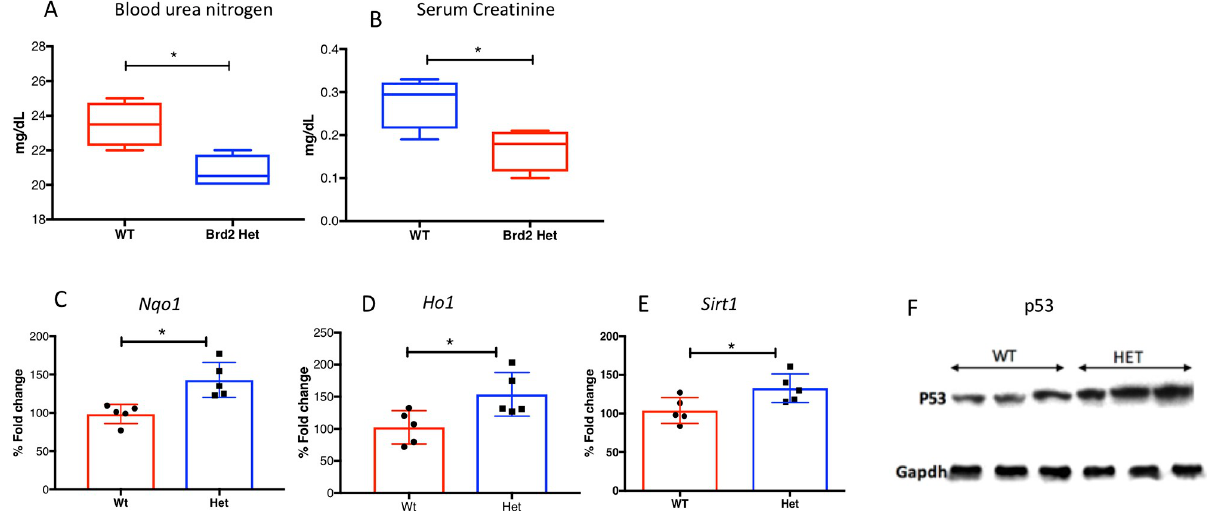
Fig 3. Biochemical and molecular changes in aged WT and HET mice: (A-B): Blood urea nitrogen (A) and serum creatinine levels (B) in WT and HET mice (n = 6/group) showing a significant increase in WT as compared to HET animals (p < 0.05). (C-E): Steady state levels Nqo1 , Hmox1 and Sirt1 mRNA (n = 5/group) in WT and HET kidneys, showing upregulation of these cytoprotective genes in samples from HET mice (p < 0.05). (F): Representative immunoblot showing elevated p53 levels in HET livers (n = 6/each group).